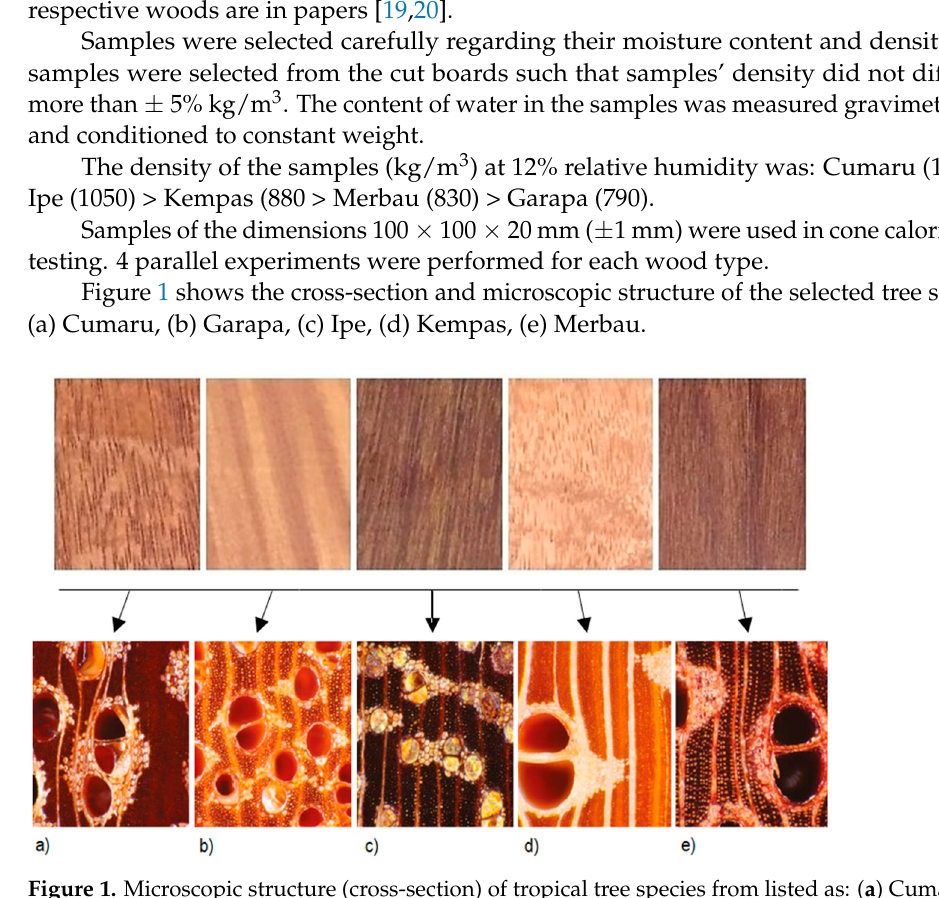
Figure 1. Microscopic structure (cross-section) of tropical tree species from listed as: ( a ) Cumaru, ( b ) Garapa, ( c ) Ipe, ( d ) Kempas, ( e ) Merbau